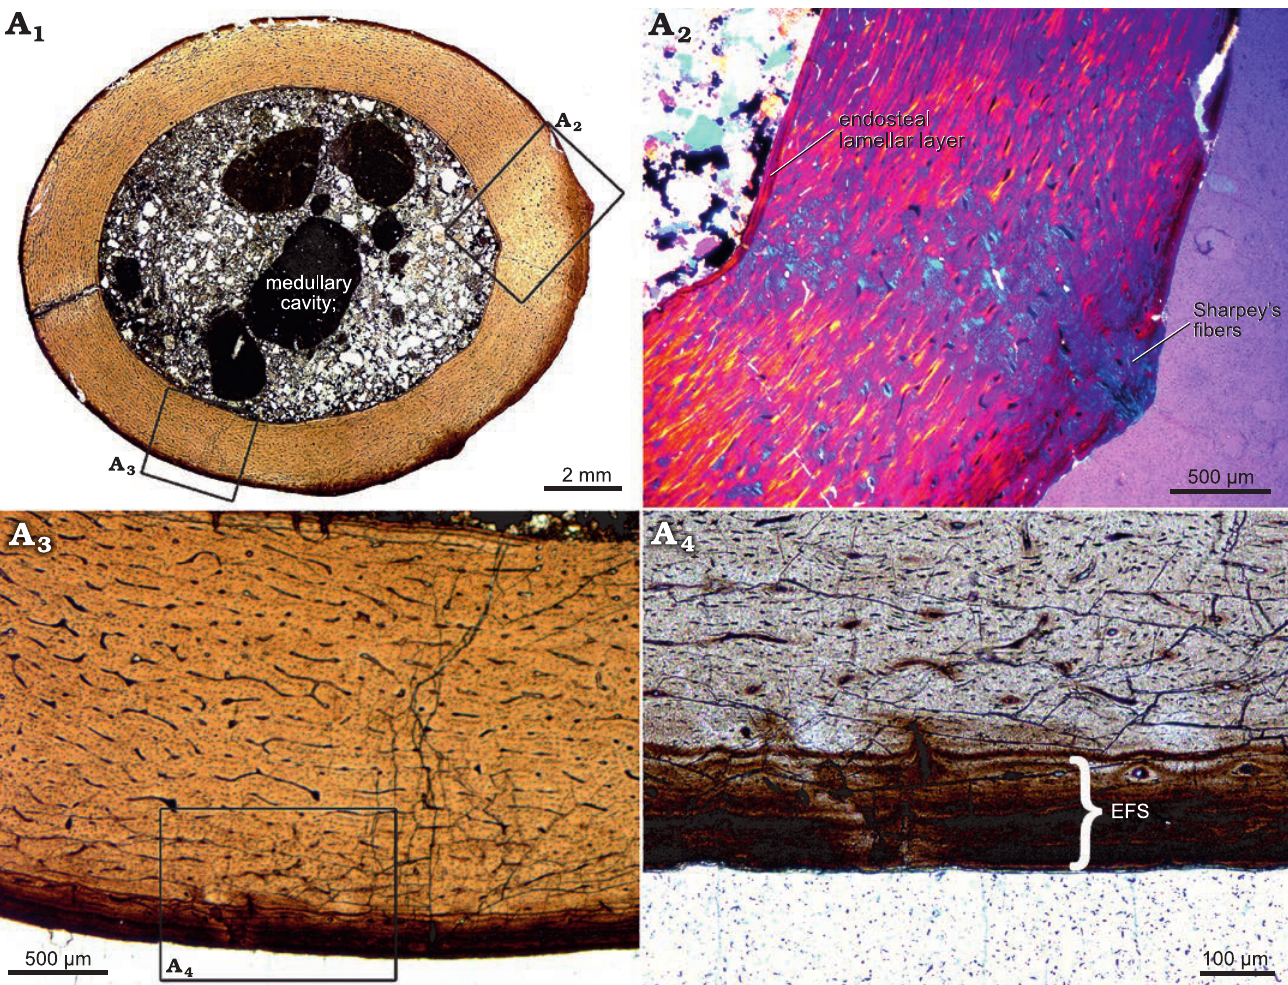
Fig. 3. Histological thin section of femur of indeterminate dsungaripteroid pterosaur species (SHN.013) from the Upper Jurassic, Praia da Armoreira- Porto Novo Formation, Peniche, Portugal. A 1 , overview of the complete section, revealing densely vascularized, fibrolamellar bone tissue. Growth marks (except for those forming an EFS) and secondary bone tissue are absent; A 2 , magnified part of the bone cortex. Here, an endosteal lamellar layer which lines the whole medullary cavity can be seen, as well as distinct Sharpey’s fibers which run across the cortex, angled at 36º; A 3 , magnified part of the fibrolamellar bone tissue, showing a plexiform network of primary osteons. At the periosteal margin, an EFS is clearly visible; A 4 , detailed picture of the EFS. Abbreviation: EFS, external fundamental